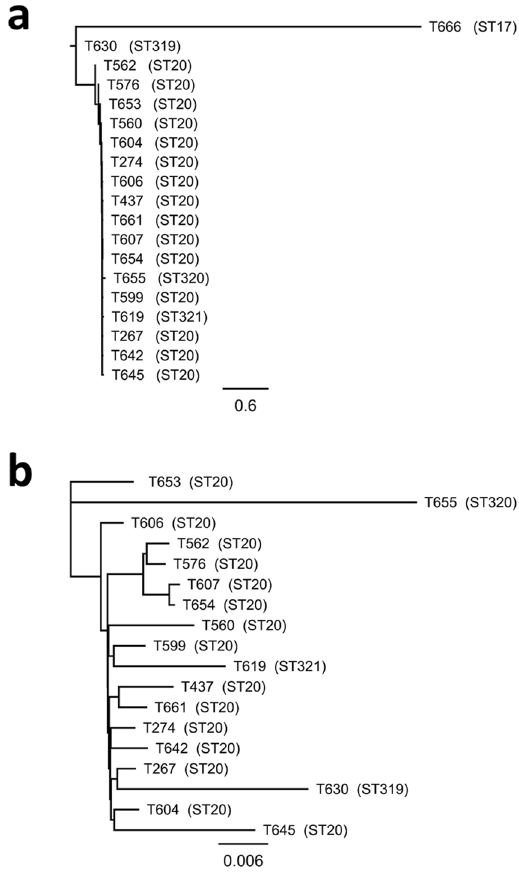
Figure 2. Phylogenetic tree of the stG62647 -isolates based on core-genome SNP-analysis. ( a ) Phylogenetic tree of all 19 stG62647 -isolates. ( b ) Phylogenetic tree of the 18 stg62647 -isolates belonging to clonal complex 20. The ST17-isolate (T666) was omitted from the analysis to increase the phylogenetic resolution of the tree. Scales indicate substitutions per site. MLST-profile is indicated in